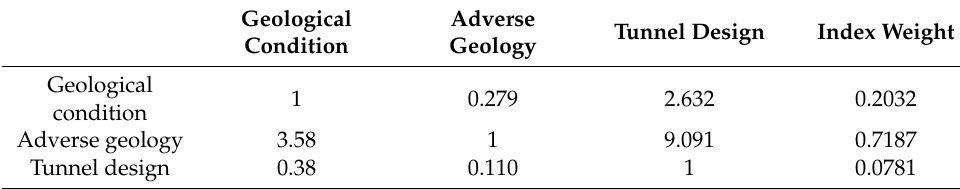
Table 13. Index weight calculation of objectives to criteria.